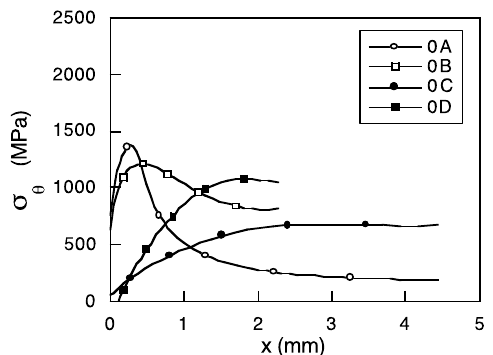
Figure 10. Distribution of hoop stress in notched samples of steel A0.